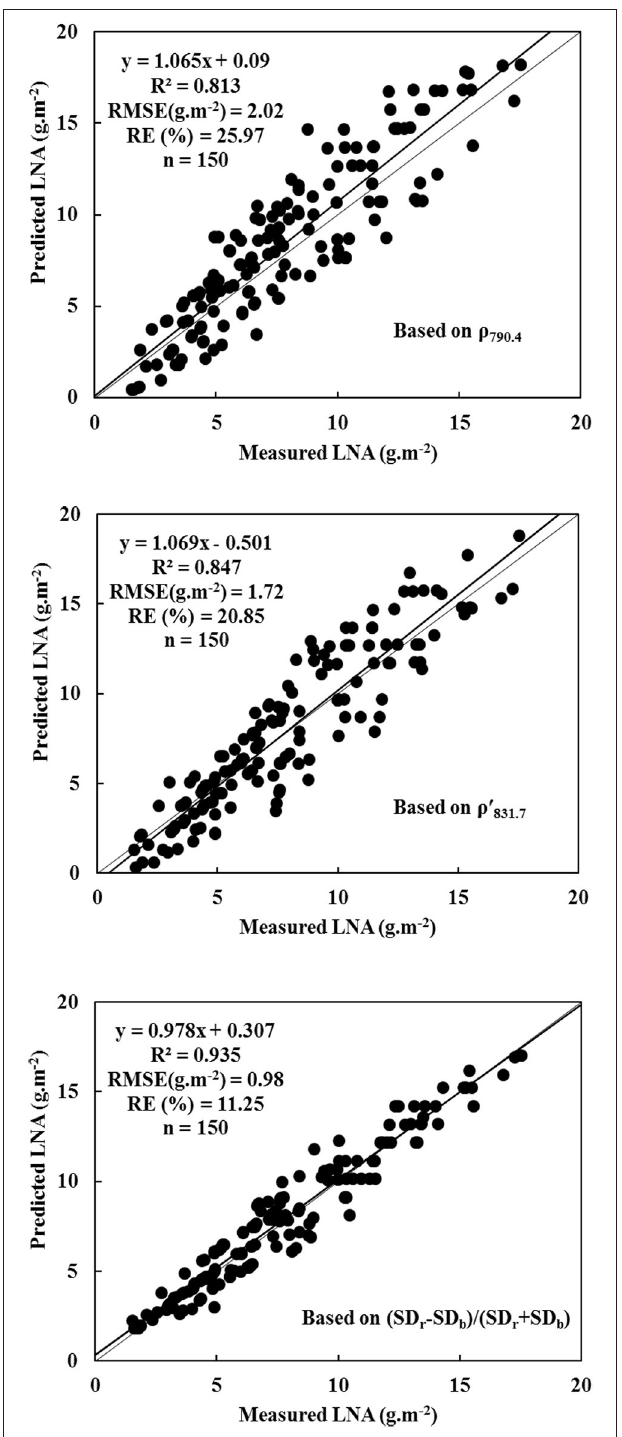
FIGURE 3 | Evaluating the diagnostic models for wheat LNA based on ρ 790.4 , ρ ′ 831.7 and ( SD r − SD b )/( SD r + SD b ) (model based on ρ 790.4 : y = 1.065x + 0.09, R 2 = 0.813, RMSE (g · m − 2 ) = 2.02, RE (%) = 25.97, n = 150; model based on ρ ′ 831.7 : y = 1.069x – 0.501, R 2 = 0.847, RMSE (g · m − 2 ) = 1.72, RE (%) = 20.85, n = 150; model based on ( SD r − SD b )/( SD r + SD b ): y = 0.978x + 0.307, R 2 = 0.935, RMSE (g · m − 2 ) = 0.98, RE (%) = 11.25, n = 150).